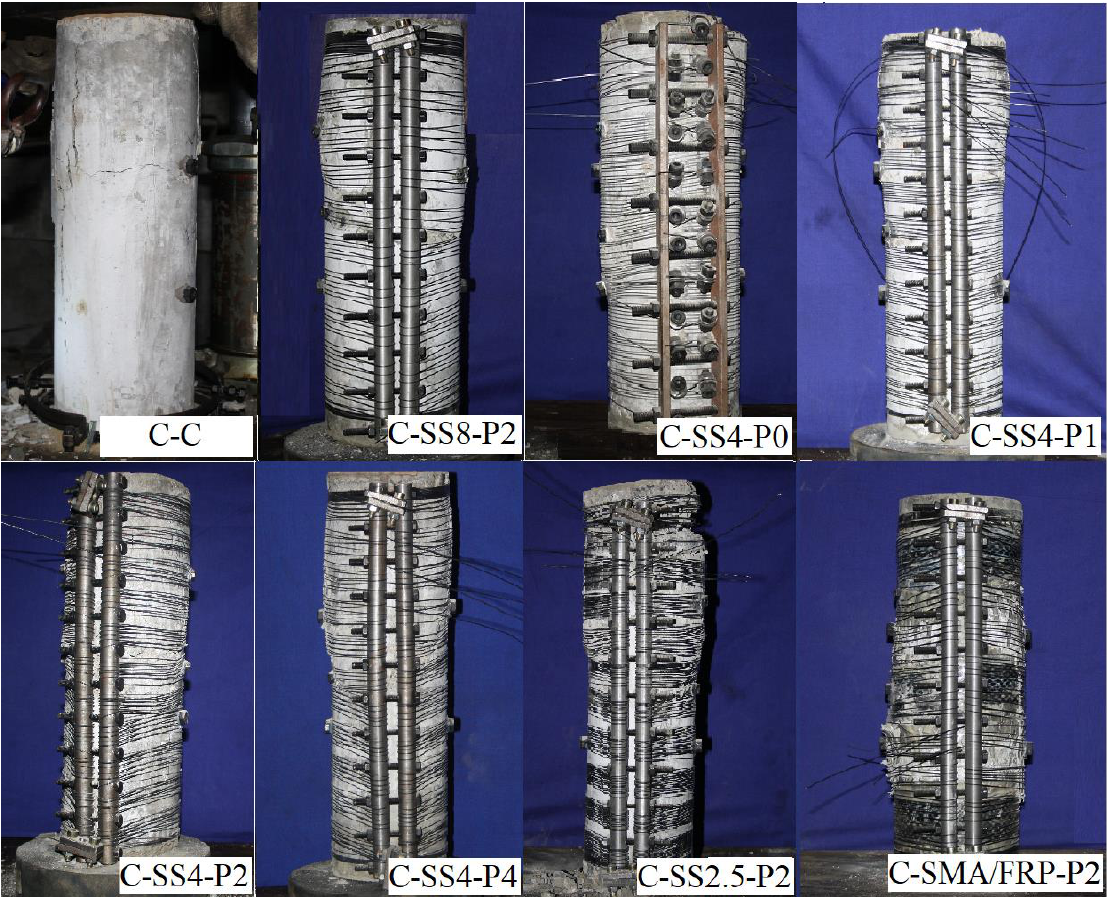
Figure 6. Superelastic SMA reinforced concrete cylinders failure patterns.